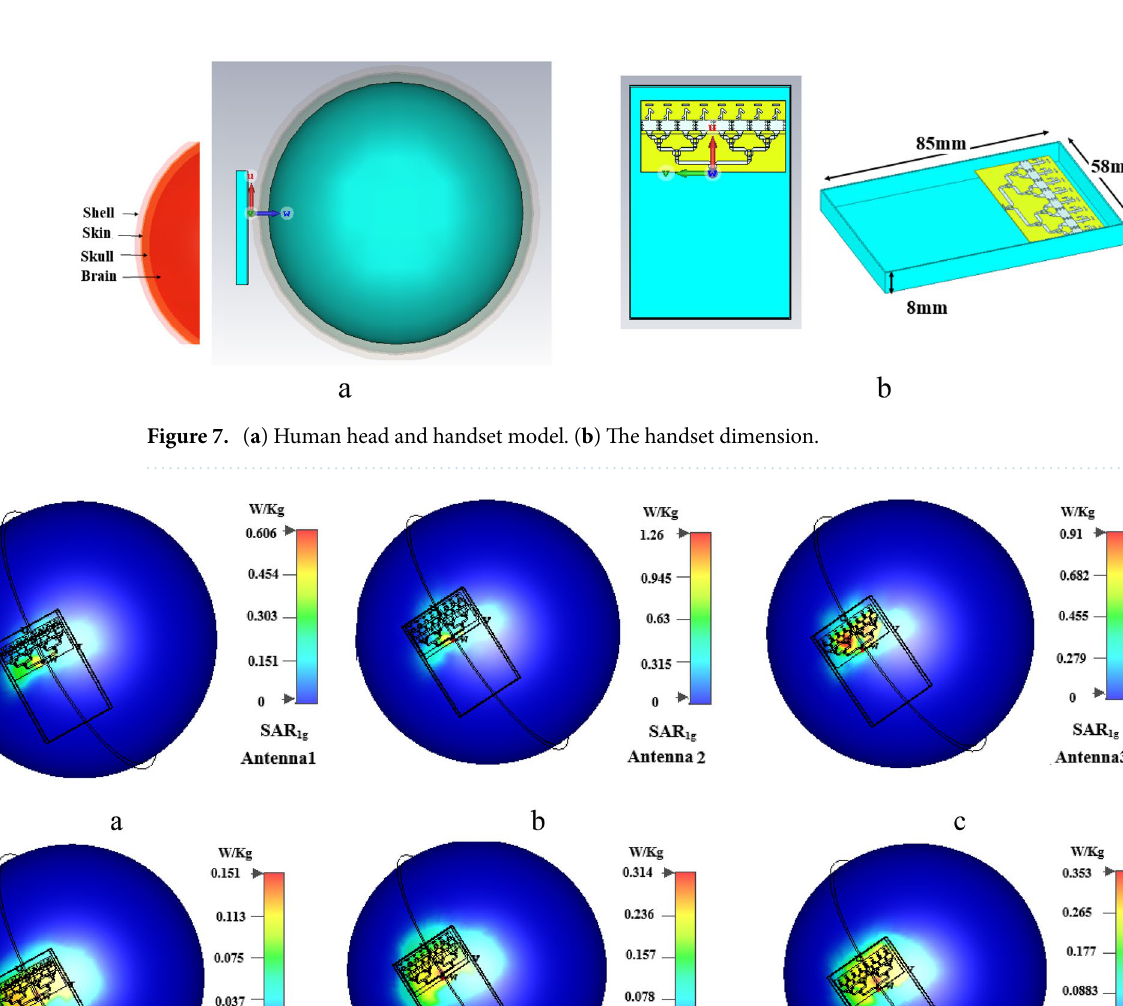
Table 2. Human head model properties at 28 GHz.